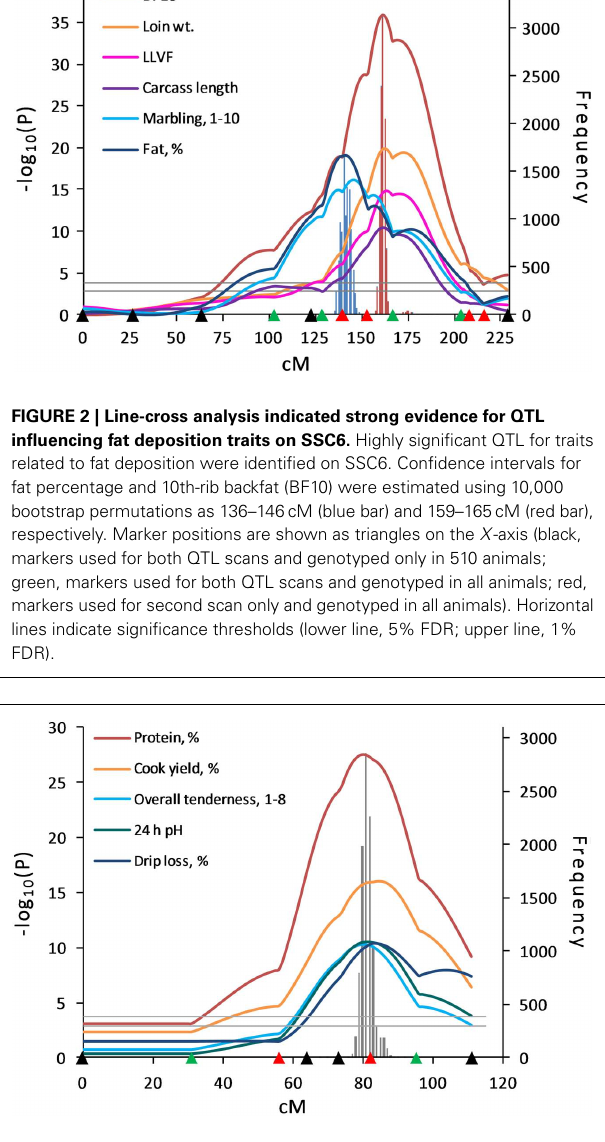
FIGURE 3 | Half-sib analysis indicated strong evidence for QTL influencing meat quality traits on SSC15. Highly significant QTL for meat quality traits were identified on SSC15. Confidence interval for protein percentage was estimated by 10,000 bootstrap permutations as 77–85cM (gray bar). Marker positions are shown as triangles on the X -axis (black, markers used for both QTL scans and genotyped only in 510 animals; green, markers used for both QTL scans and genotyped in all animals; red, markers used for second scan only and genotyped in all animals). Horizontal lines indicate significance thresholds (lower line, 5% FDR; upper line, 1% FDR).